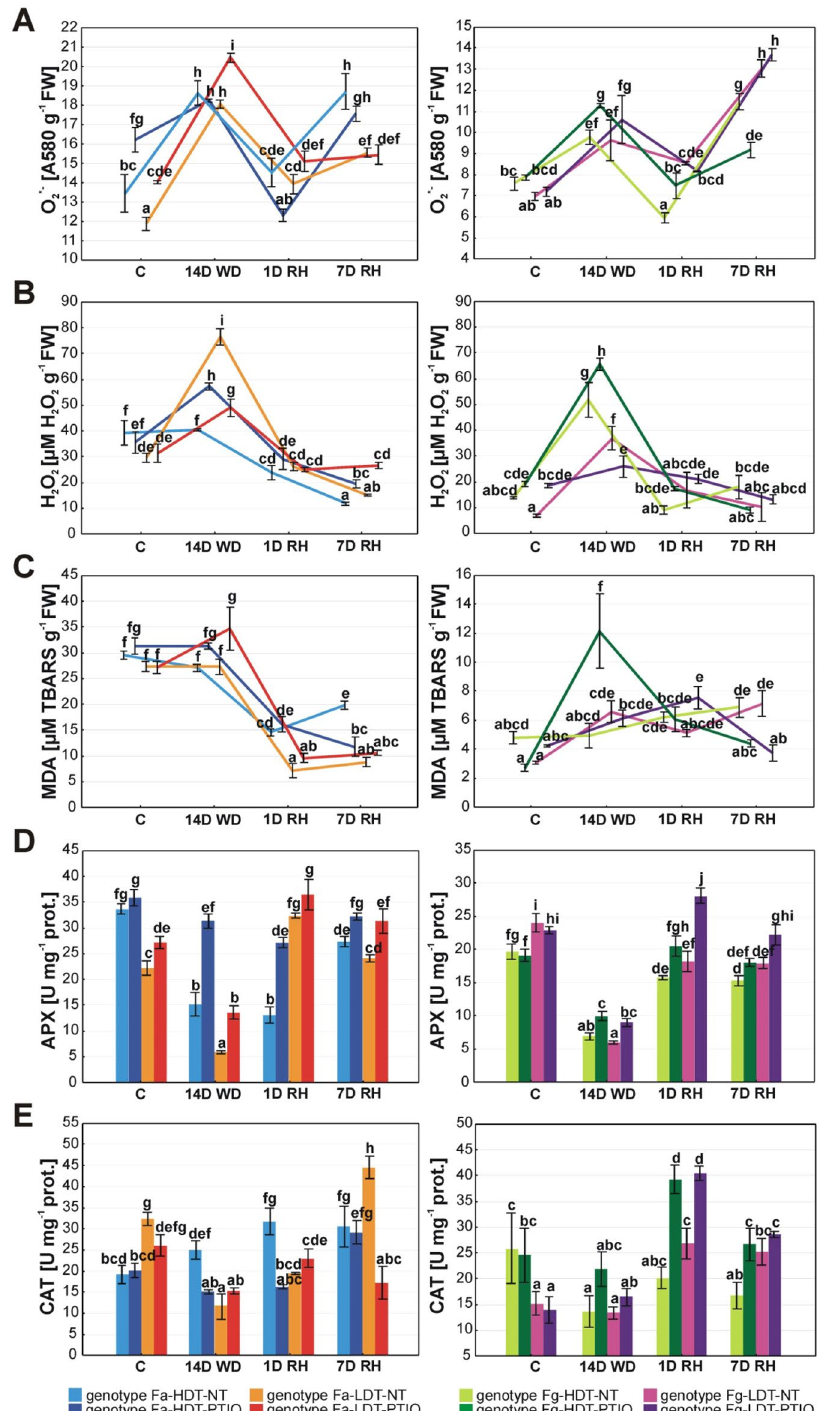
Figure 4. Changes in reactive oxygen species content: superoxide anion radical (O 2∙− ) ( A ), hydrogen peroxide (H 2 O 2 ) ( B ), malondialdehyde (MDA) ( C ) and antioxidant enzymes activity: ascorbate peroxidase (APX) ( D ) and catalase (CAT) ( E ) in the analyzed high drought tolerant (HDT) and low drought tolerant (LDT) Festuca arundinacea (Fa) and F. glaucescens (Fg) genotypes non-treated with PTIO (NT) and treated with 200 µM PTIO (PTIO) at control conditions (C), on the 12th day of water deficit (12D WD), 14th day of water deficit (14D WD), 1st day of re-watering (1D RH) and 7th day of re-watering (7D RH). Error bars represent the standard errors. Homogeneous groups are denoted by the same letter according to Fisher-LSD test (p = 0.05). PTIO